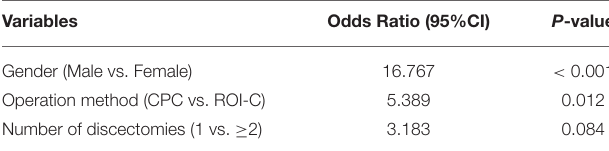
TABLE 5 | Multivariate analysis of the risk factors. Variables Odds Ratio